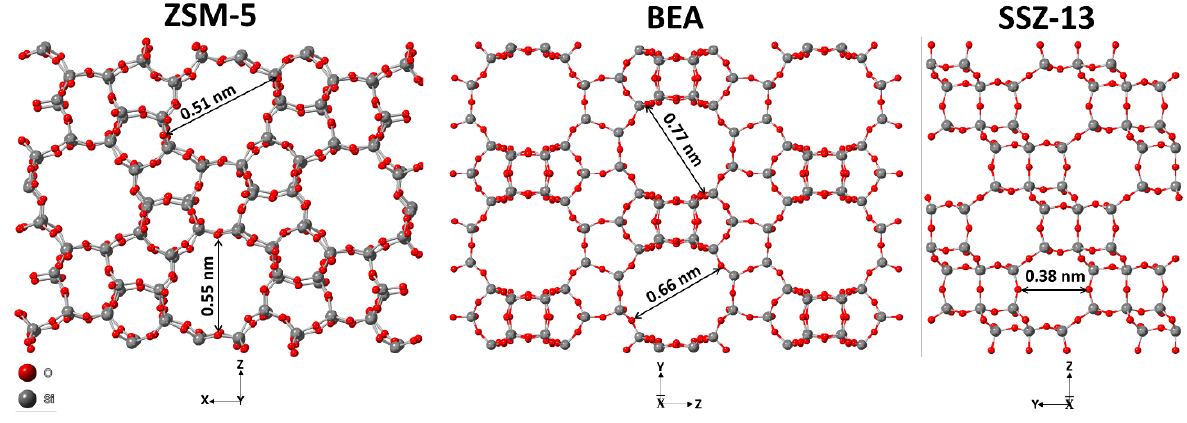
Figure 1. Representation of zeolite structures deployed in this study.